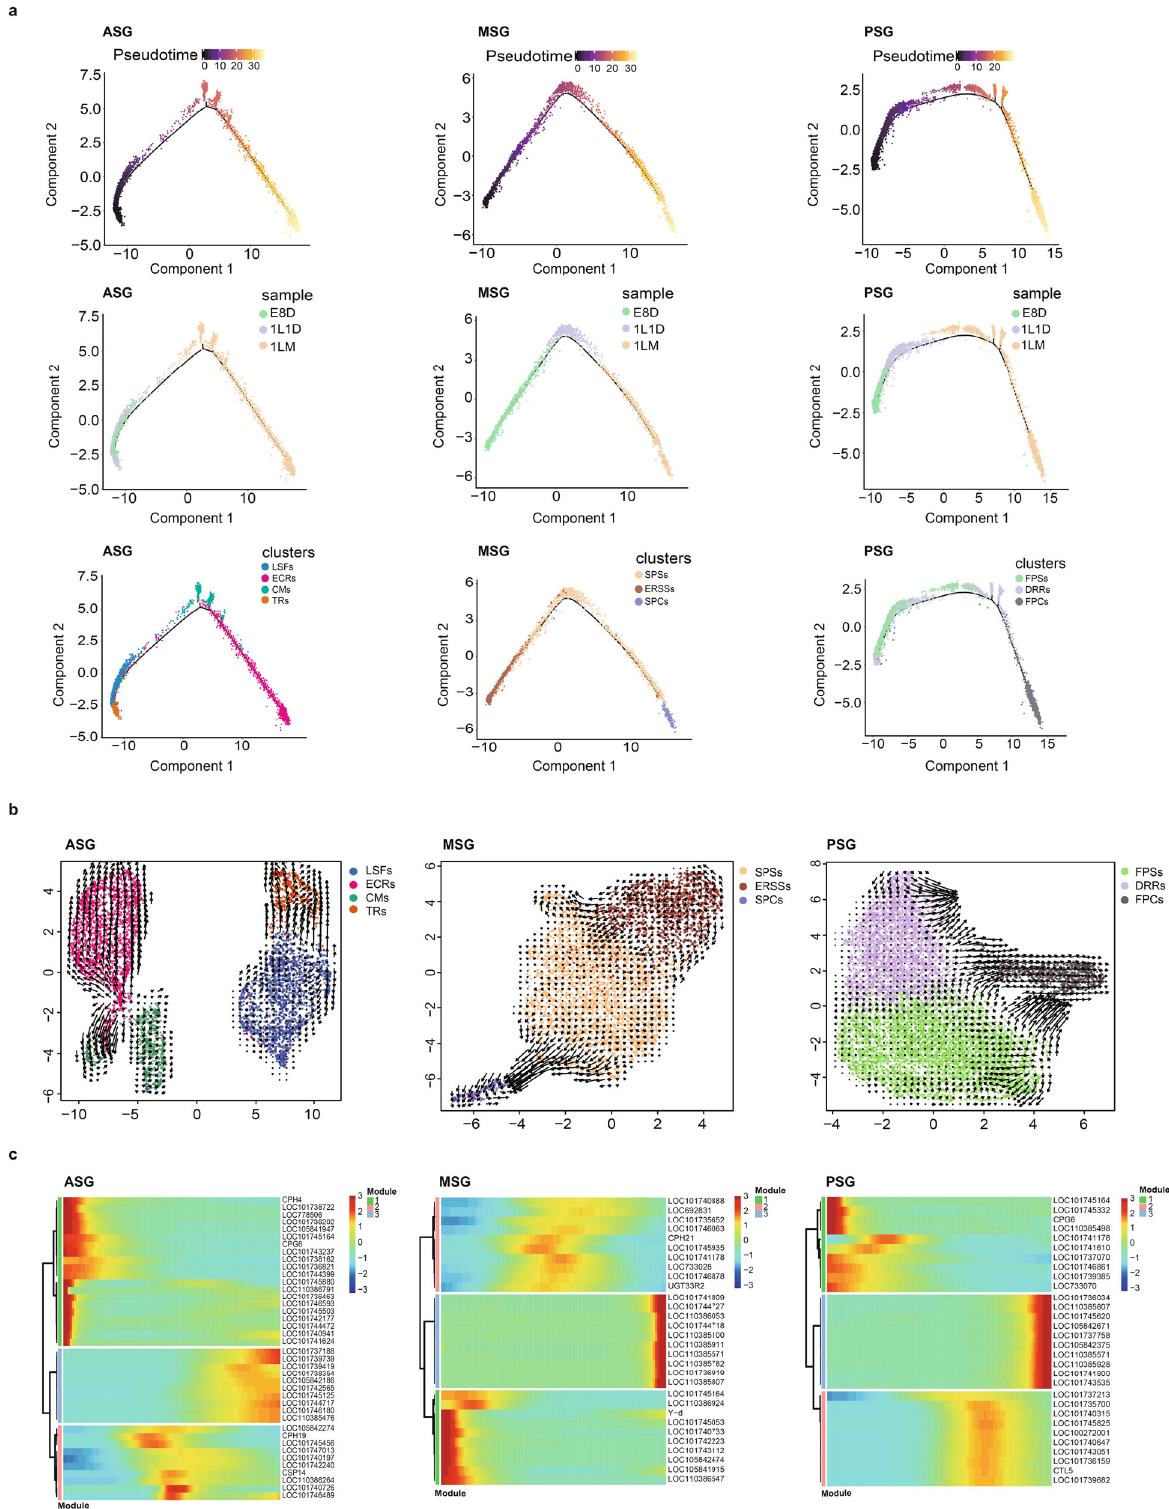
Fig. 4 Pseudotime analysis of silk gland cells using Monocle2. a Trajectories of ASG, MSG, and PSG cells along pseudotime. The colors from dark (purple) to light (yellow) represent the forward order of pseudotime. b RNA velocity map of ASG, MSG, and PSG cells. The length of the arrows indicates the rate of cell development, the direction of the arrows indicates the direction of cell development. c Pseudotime heatmap of the top 10 marker genes (on the right of heatmap) of each cluster in the ASG, MSG, and PSG. ASG anterior silk gland, MSG middle silk gland, PSG posterior silk gland.